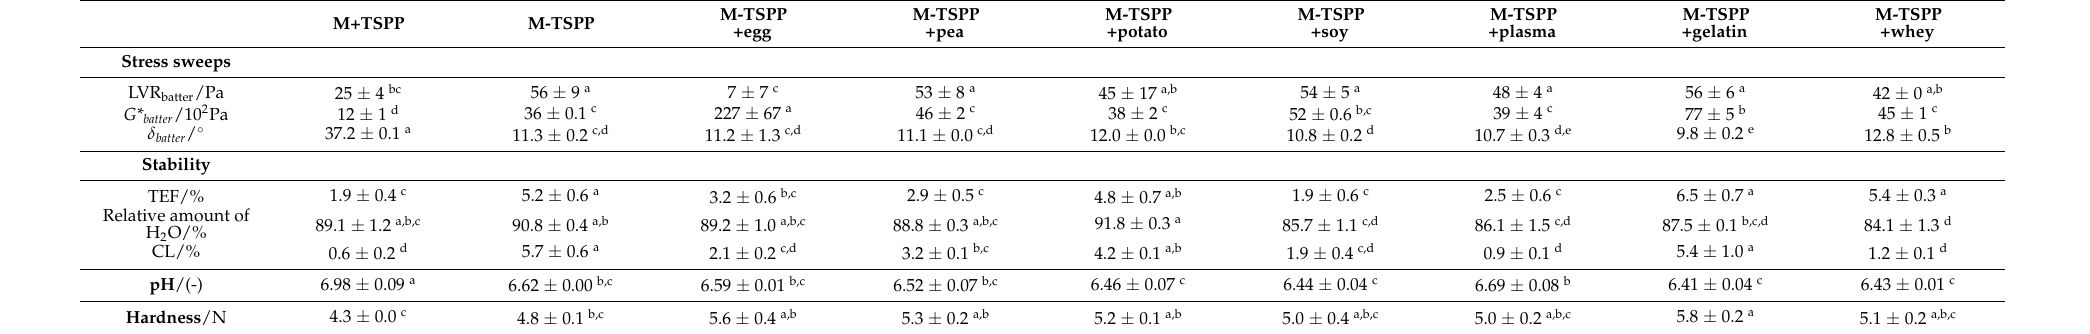
Table 1. Structural parameters of sausage batters (stress sweeps) and hardness, pH, water, and fat binding characteristics (CL, TEF, and relative amount of H 2 O) of cooked sausages with phosphate (M+TSPP), without phosphate (M-TSPP), and several protein-based ingredients instead of phosphate (M-TSPP+protein). Mean values and standard deviations are presented (n = 2). Different letters indicate significant differences at p < 0.05. Abbreviations used: M (Model), TSPP (tetrasodium pyrophosphate), LVR batter (linear viscoelastic region of the sausage batter), G* batter (complex modulus of the sausage batter), δ batter (phase angle of the sausage batter), TEF (total expressible fluid), and CL (cooking loss). Superscripts a–e: different letters indicate significant differences ( p < 0.05) between different